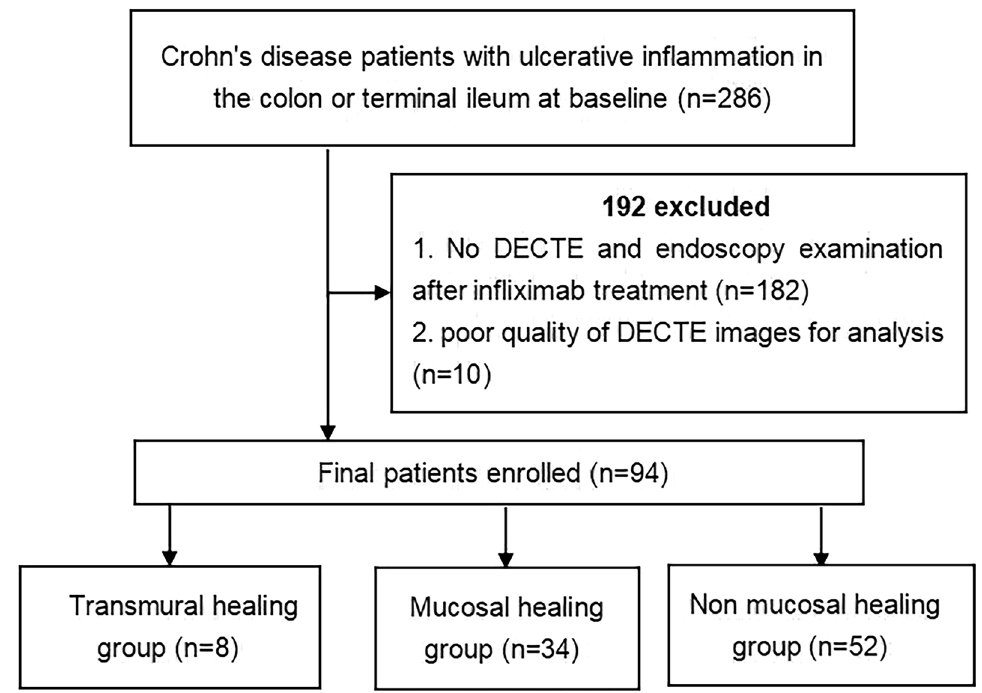
Fig. 1 The flow diagram of the